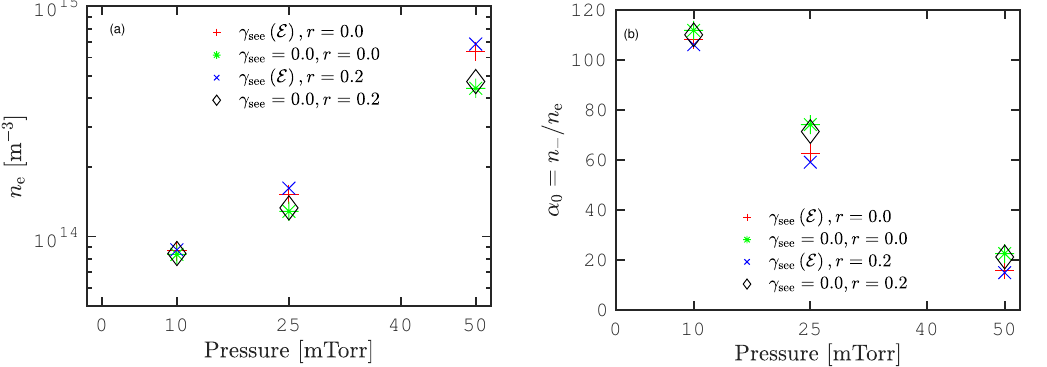
Figure 3. The ( a ) electron density and the ( b ) electronegativity in the discharge center as a function of pressure for a parallel plate capacitively-coupled oxygen discharge with a surface quenching coefficient for the singlet metastable molecule O 2 ( a 1 ∆ g ) as γ wqa = 0.0001 and a gap separation of 4.5 cm driven by a 222 V voltage source at a driving frequency of 13.56